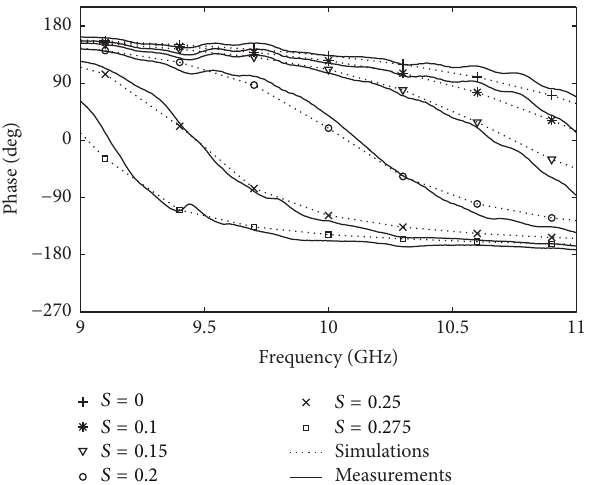
curves versus frequency for values of 𝑆 ( 𝐿 = 7.6 mm, Δ𝑥 × Δ𝑦 = × 0.3𝜆 0.3𝜆 0 0 ).